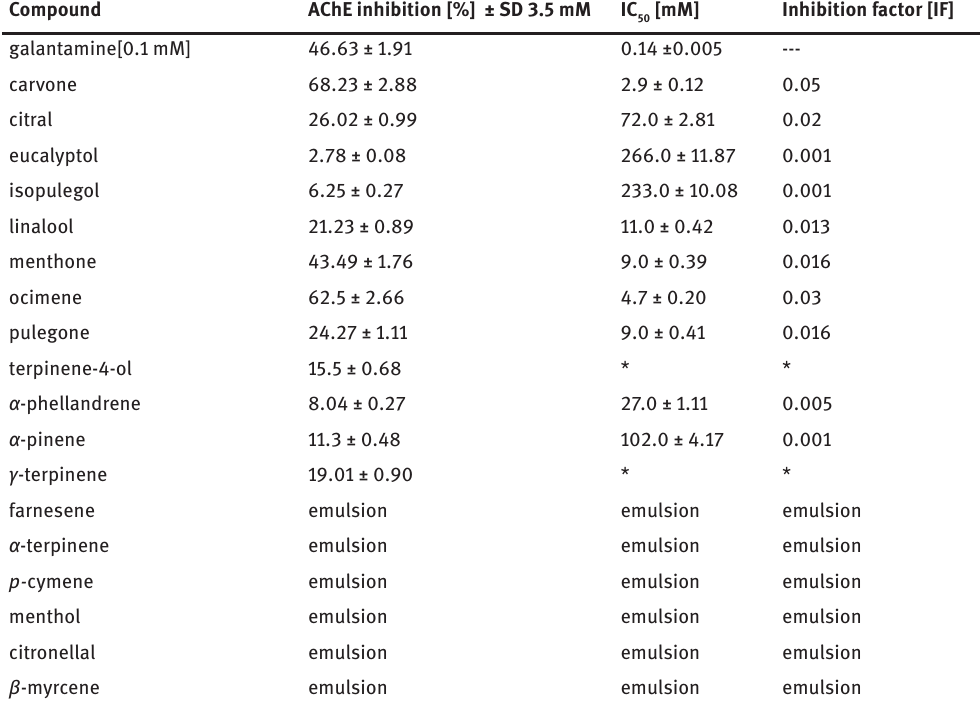
Table 1: Spectrophotometric Ellman assay